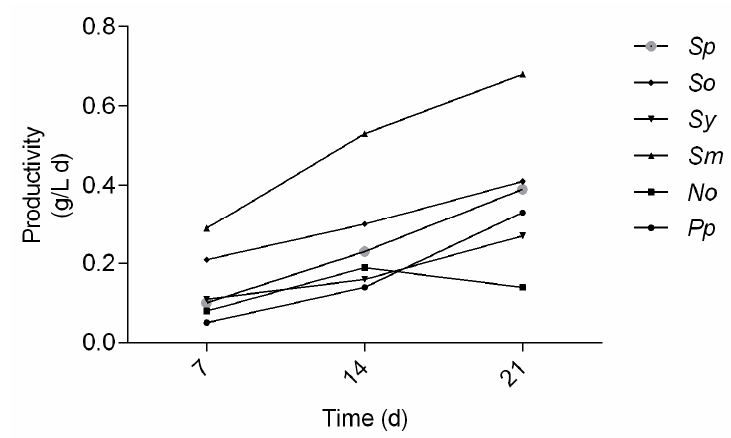
Figure 1. Productivity (g / (L · d) − 1 ). Pp: Porphyridium purpureum ; No: Nostoc sp.; Sm: Spirulina maxima ; Sy: Synechocystis sp.; So: Scenedesmus obliquus , Sp: Spirogyra sp.